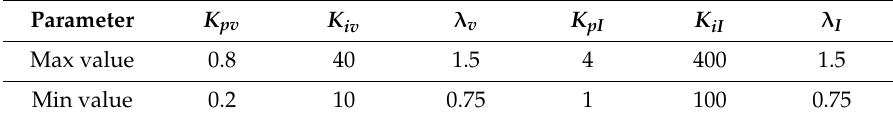
Table 2. Search space boundary values for gain parameters.